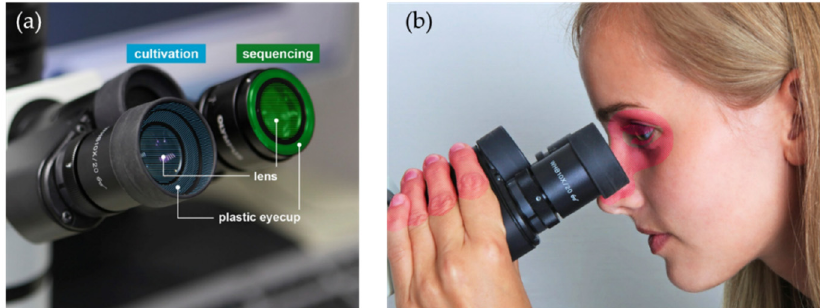
Figure 1. Sampled parts of the microscope oculars and skin areas that act as source for microbial contamination: ( a ) Each right ocular (lens and plastic eyecup) was sampled for sequencing-based analysis, each left ocular (lens and plastic eyecup) was sampled for cultivation-based analysis; ( b ) Skin and eye areas (highlighted in red) with probable contact to microscope oculars. Photographs with permission of Furtwangen University.